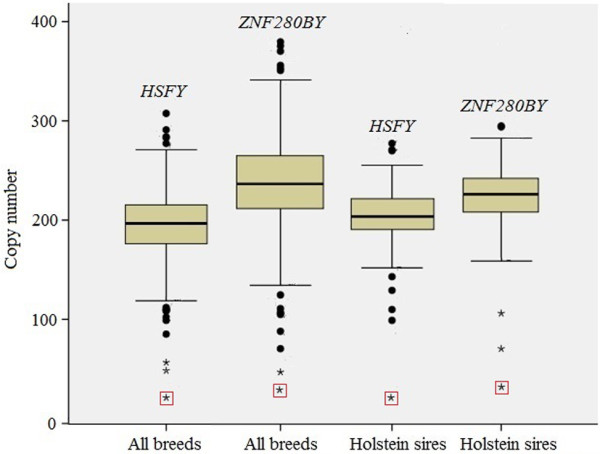
Box plot analysis of the HSFY and ZNF280BY CN in cattle. The outliers were indicated by a solid circle or an asterisk (extremely low CN), which include 12 bulls in all breeds and 9 bulls in Holstein for HSFY, while 14 and 6 for ZNF280BY, respectively. The animal that has the lowest CN of HSFY and ZNF280BY was marked with a red square.